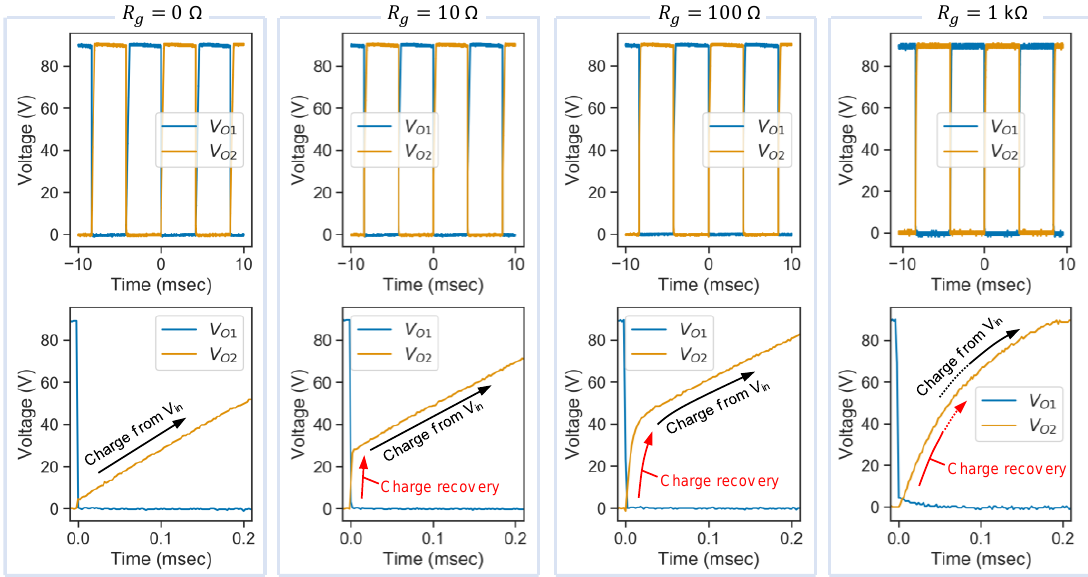
Figure 9. Voltage waveform with load of capacitors with different 𝑅 𝑔 .